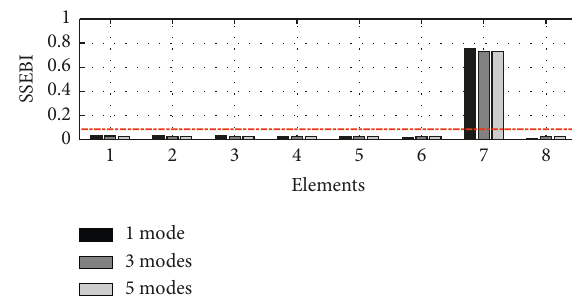
Figure 13: Damage detection results for the simply supported experimental beam in the first step (results obtained using the first mode, the first three modes, and the first five